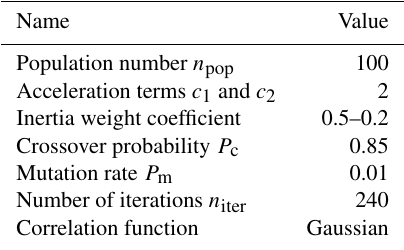
Table 6. Parameters of the improved particle swarm algorithm op- timization.